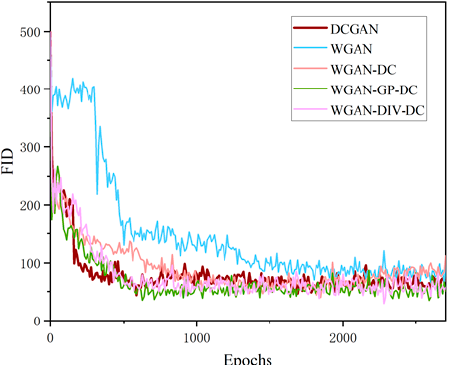
Figure 8. The comparison of FID curves: ( a ) DCGAN and WGAN; ( b ) WGAN and WGAN-DC.